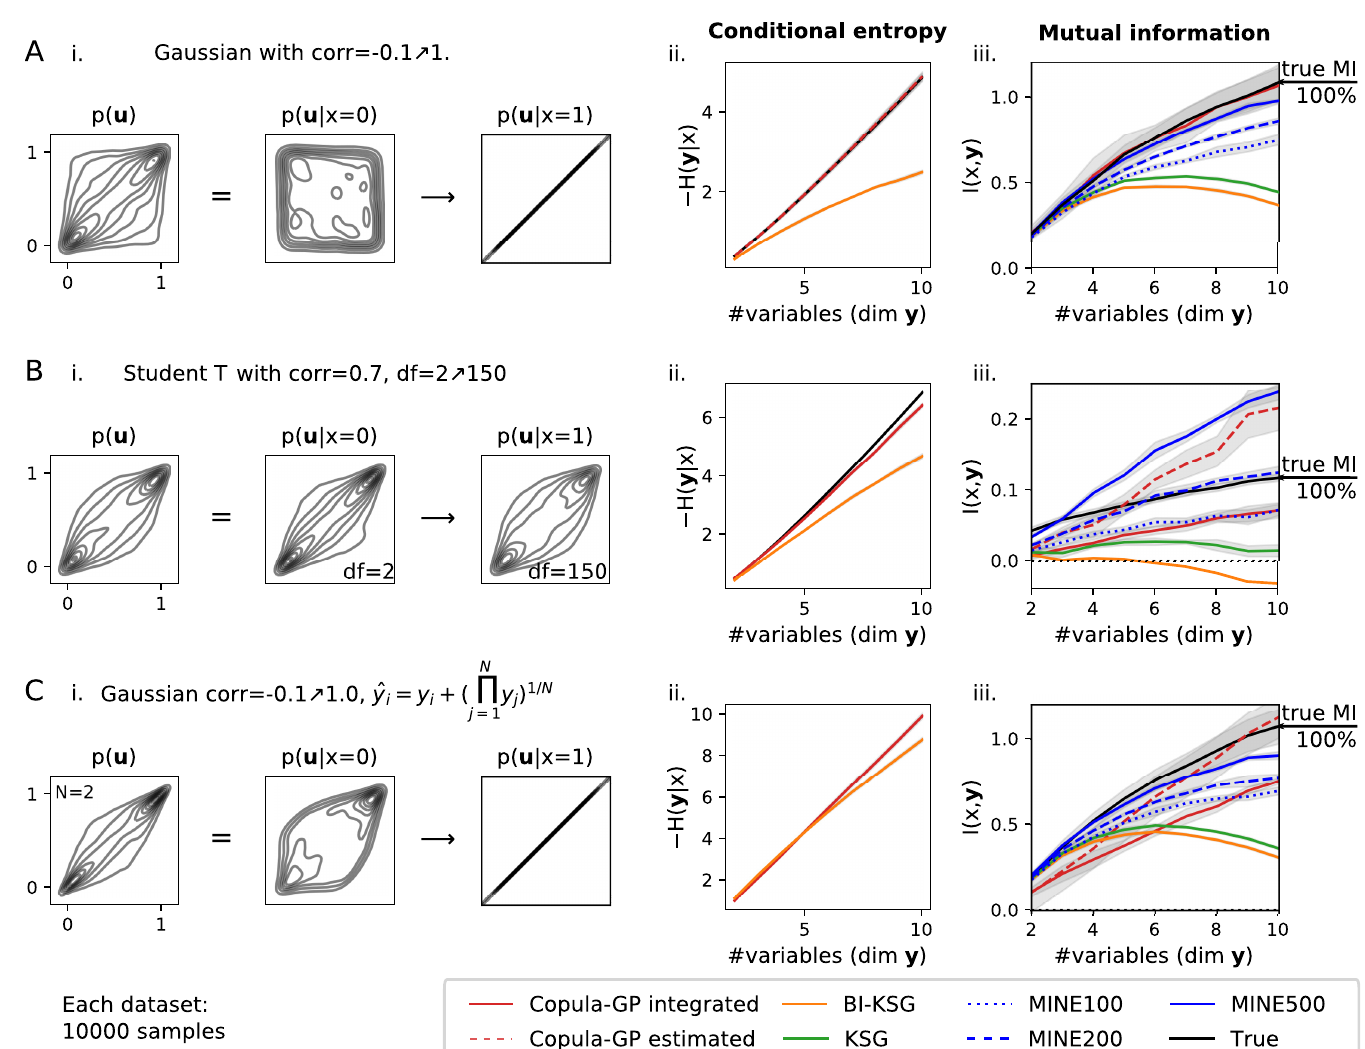
Fig 4. Comparison of the Copula-GP model against the non-parametric information estimators , performed on three benchmarking datasets A Multivariate Gaussian. B Multivariate Student T. C Multivariate Gaussian y (same as A ), morphed into another distribution p ð ^ y Þ with a tail dependence, while I ð x ; y Þ ¼ I ð x ; ^ y Þ . In each row, the plots show: i . the probability density plots from each dataset: the unconditional dependency structure p ( u ) (left) and conditional dependency structures at the beginning and the end of the parameter domain dom x = [0, 1] (middle and right, respectively). ii . conditional entropy H ( y | x );the black line shows the true values, the red line—Copula-GP, the orange line—BI-KSG; Note, that MINE is not included in this comparison, as it does not produce estimates of H ( y | x ). iii . mutual information I ( x , y ); black line—true value; red—Copula-GP (solid: MC integration (12); dashed: estimated MI (13)); orange—BI-KSG; green—KSG; blue—MINE (dotted: 100 HU, dashed: 200 HU, solid: 500 HU). Gray intervals show either standard error of mean (SE, 6 repetitions), or Note, that MINE estimates are sensitive to the choice of hyper-parameters (e.g. number of hidden units, shown in different line